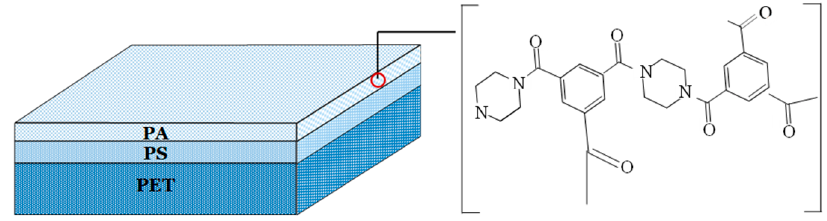
Figure 4. Structure of NF270 membrane. PA-polyamide, PS-polysulfone, PET-polyester.